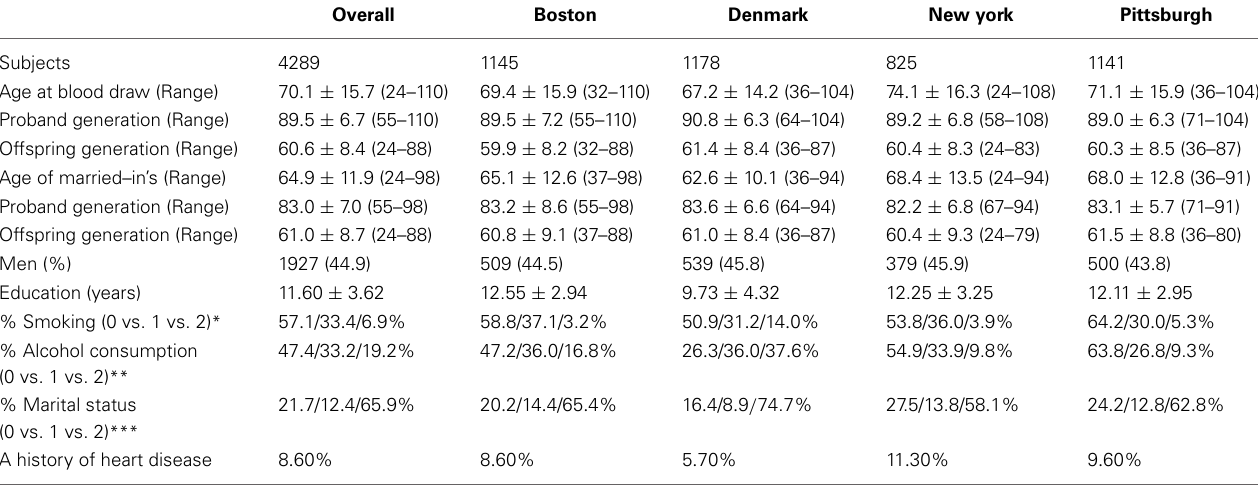
Table 1 | Demographic and clinical characteristics: restricted to